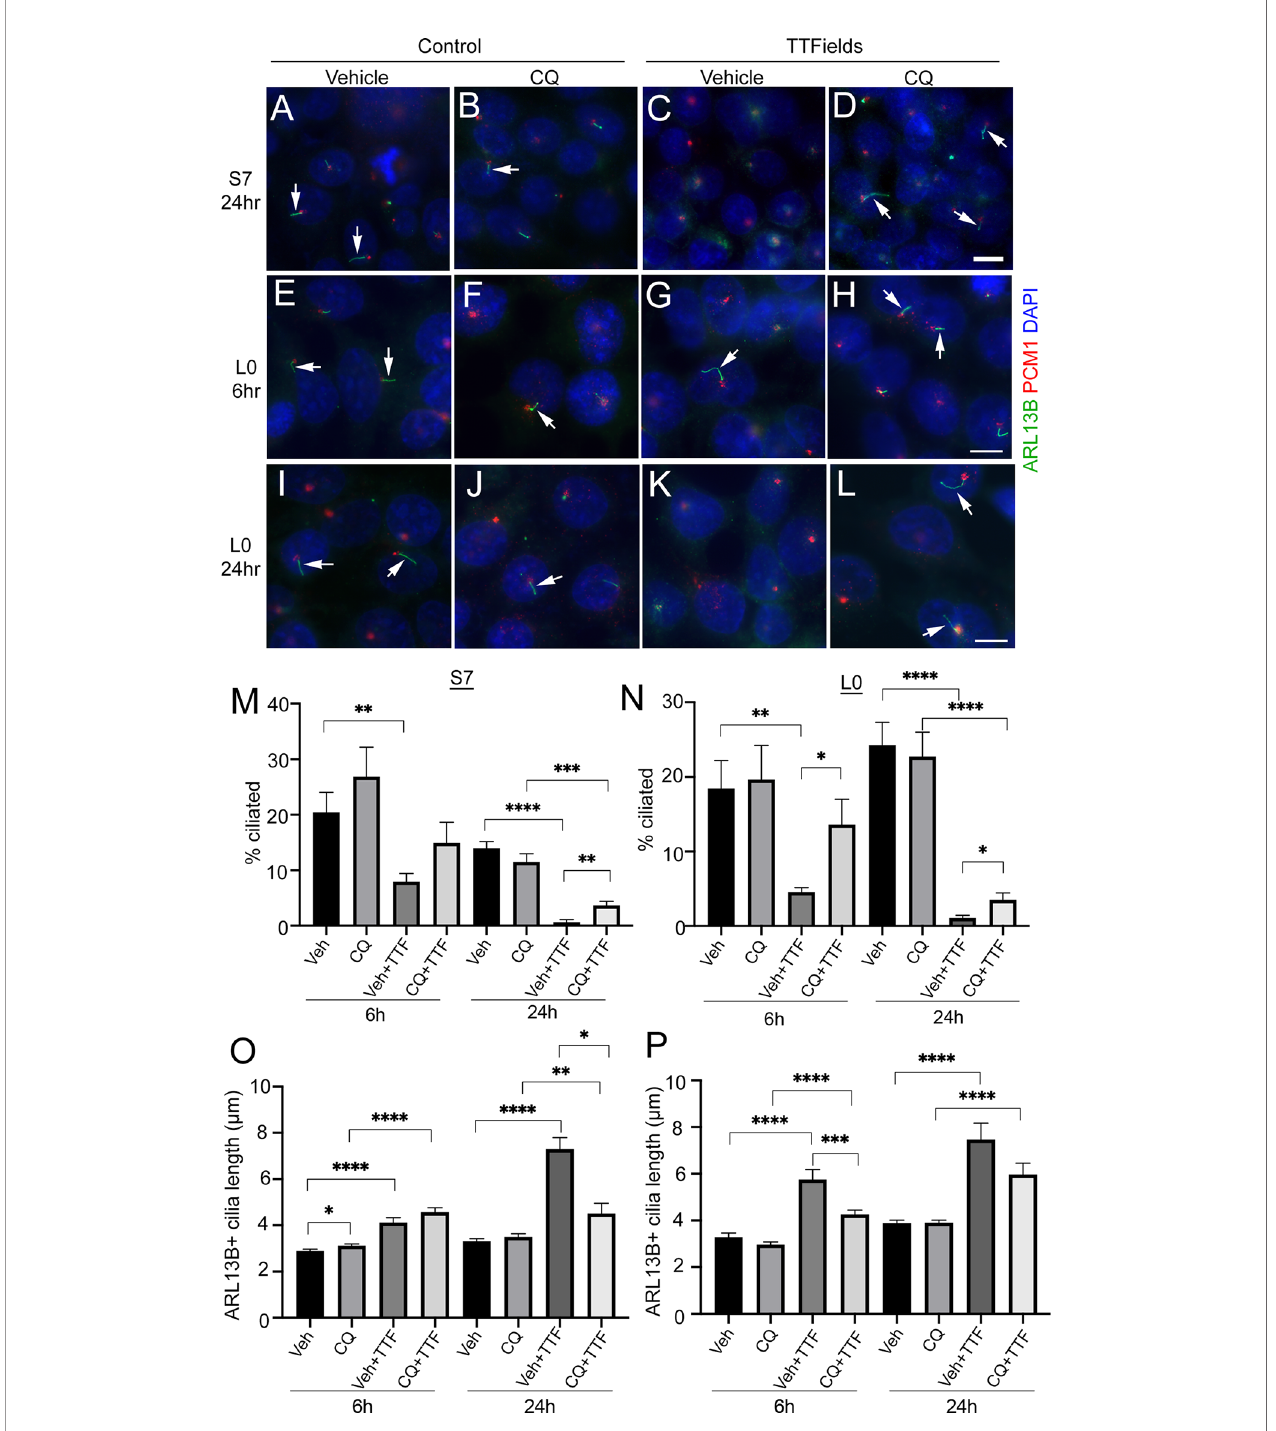
FIGURE 4 | Chloroquine pretreatment partially prevents TTFields-induced loss of cilia. (A – D) S7 or (E – L) L0 cells pretreated with vehicle (A, C, E, G, I, K) or 20 µM chloroquine (CQ) (B, F, J, D, H, L) and left untreated (control) (A, B, E, F, I, J) or exposed to TTFields (C,D, G, H, K, L) . Cells were fi xed after the indicated time point and stained for ARL13B (green) and PCM1 (red) with nuclei stained with DAPI (blue). Arrows point to cilia observed in the indicated treatments. Scale bars for the respective rows in (D, H, L) = 10 µm. (M) Percent of S7 and (N) L0 cells with ARL13B + cilia for the indicated treatment group after 6 h or 24 h of TTFields (TTF). Mean lengths of ARL13B + cilia in (O) S7 or (P) L0 cells for the indicated treatment group after 6 or 24 h of TTFields (TTF). * p < 0.05; ** p < 0.01; *** p < 0.005; **** p < 0.0001 (ANOVA).